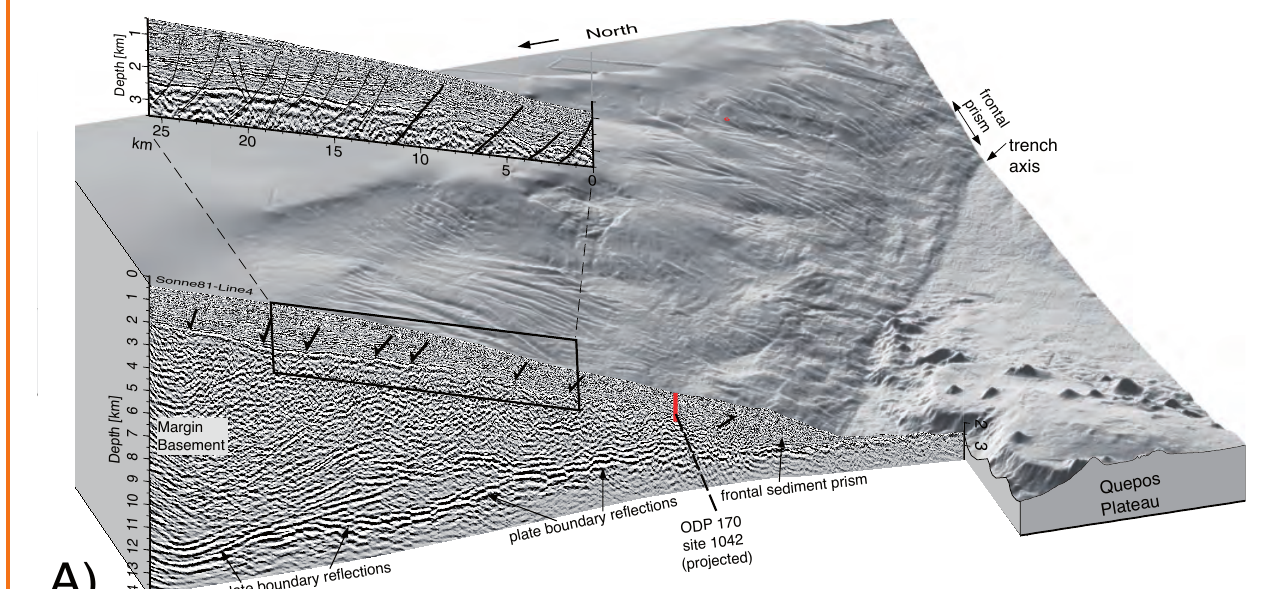
Figure 1. [A] Seismic depth image (pre-stack depth migration) of the Costa Rica margin near the Osa Peninsula (Ranero and von Huene, 2000). Margin basement is formed by igneous rock; major normal faults are emphasized with lines. Inset on the left shows detail of normal faults displacing the top of basement uncorformity and the slope sediment section. Seafloor topography was acquired with multibeam